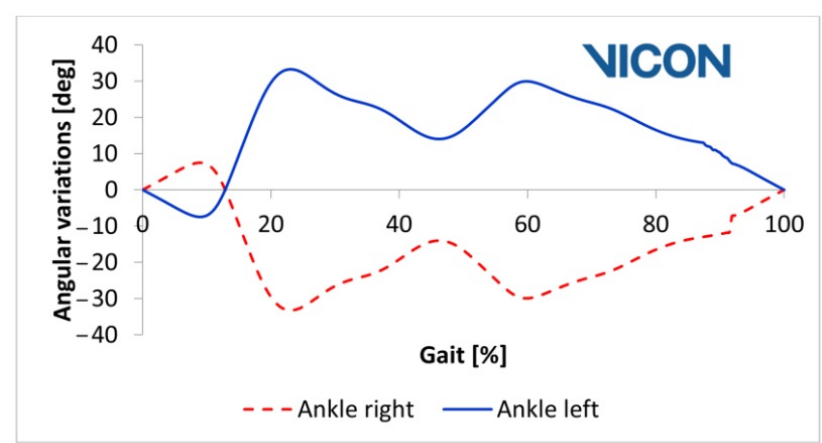
Figure 4. Knee joints angular variations during one gait vs. time.